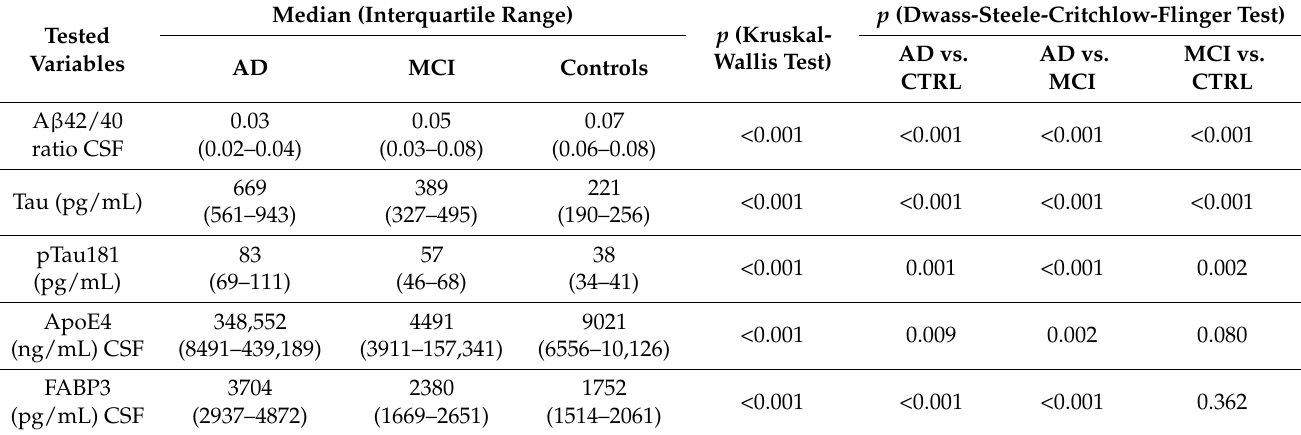
Table 1. The concentrations of tested proteins in the study